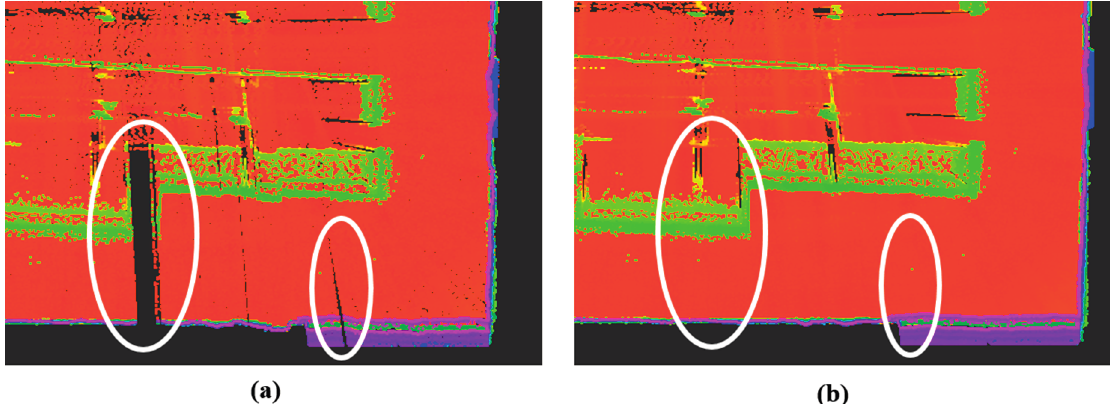
Figure 14. Detailed view of the seminar room ( a ) without and ( b ) with the constraint approach.